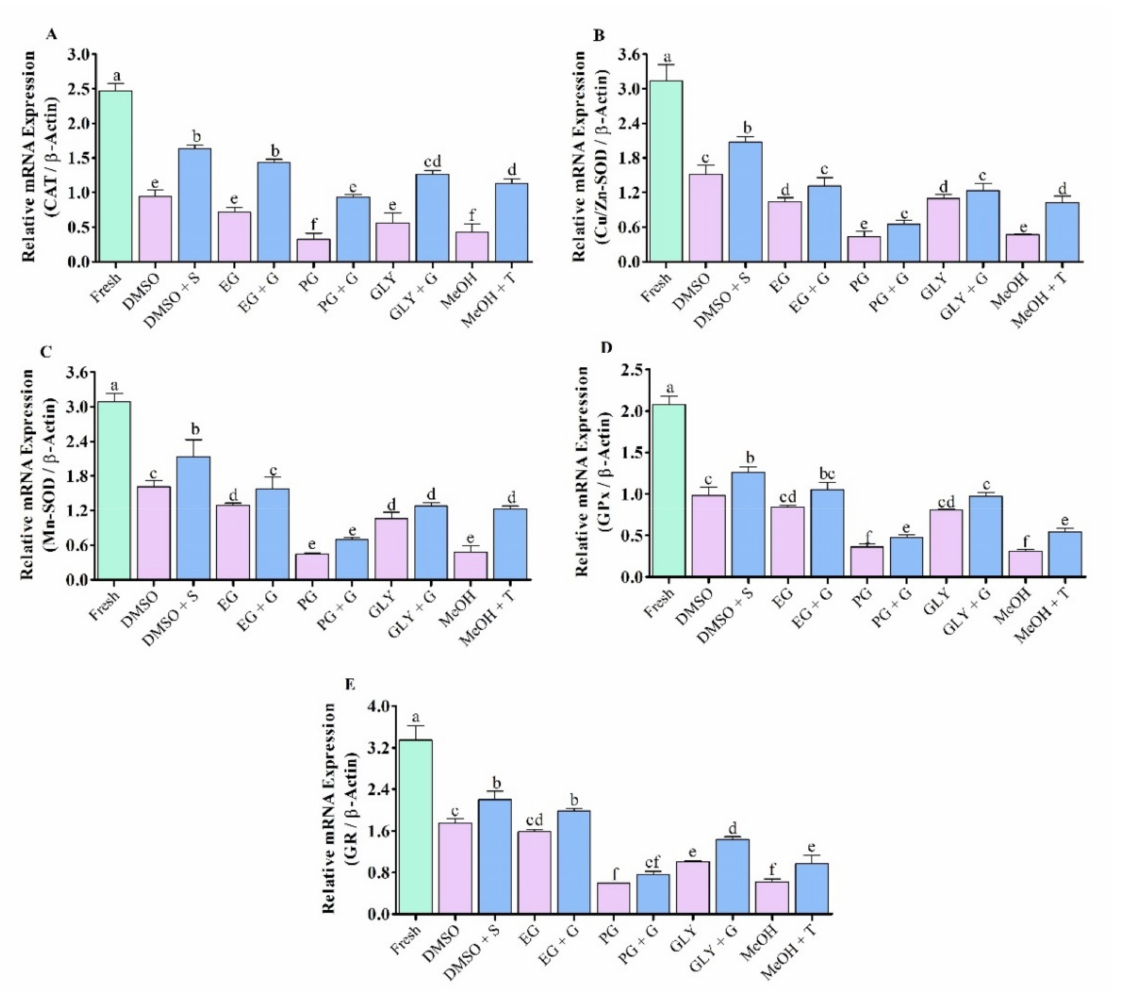
Figure 9. mRNA abundance of antioxidant gene in post-thaw Pacific abalone sperm cryopreserved using saccharides. ( A ) Catalase (CAT), ( B ) Copper/zinc superoxide dismutase (Cu/Zn-SOD, ( C ) Man- ganese superoxide dismutase (Mn-SOD), ( D ) Glutathione peroxidase (GPx), ( E ) Glutathione reductase (GR). Expression values of mRNA were normalized against average ∆ CT values of control. DMSO: 8% dimethyl sulfoxide, EG: 8% ethylene glycol, PG: 6% propylene glycol, GLY: 2% glycerol, MeOH: 2% methanol, DMSO + S: 8% DMSO combined with 3% sucrose (S), EG + G: 8% EG combined with 1% glucose (G), PG + G: 6% PG combined with 2% glucose (G), GLY + G: 2% GLY combined with 3% glucose (G), MeOH + T: 2% MeOH combined with 4% trehalose (T). Significantly different levels ( p < 0.05) are denoted by different